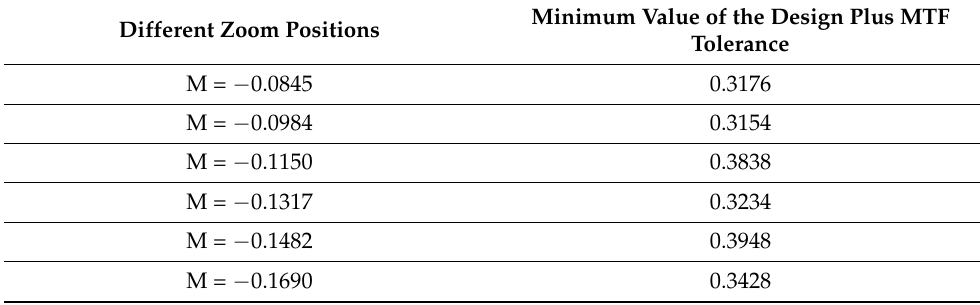
Table 5. Comparison of the design plus MTF tolerance at different magnifications.